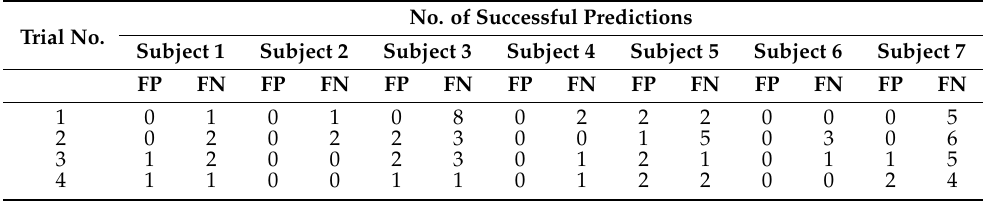
Table 12. Number of false positives (FP) and false negatives (FN): grab. Trial No.